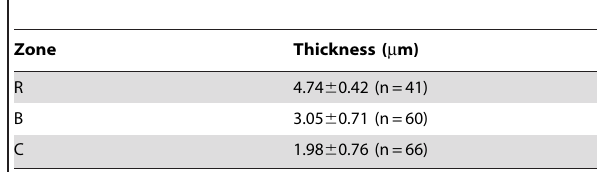
Table 1. Average membrane thickness from three wing zones R, B and C (see Figure 1 a), measured from SEM cross